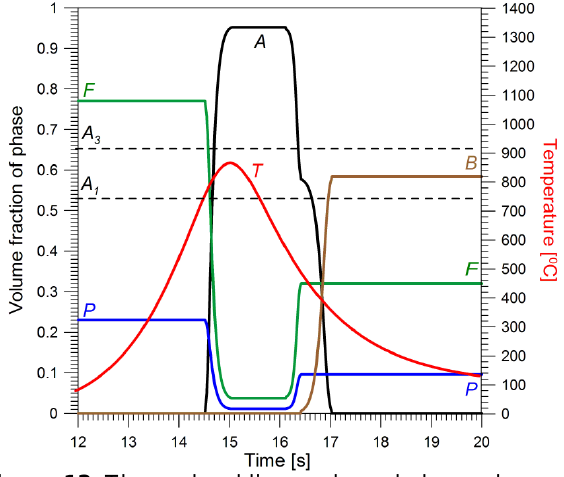
Figure 13. Thermal welding cycle and phase shares at point 3